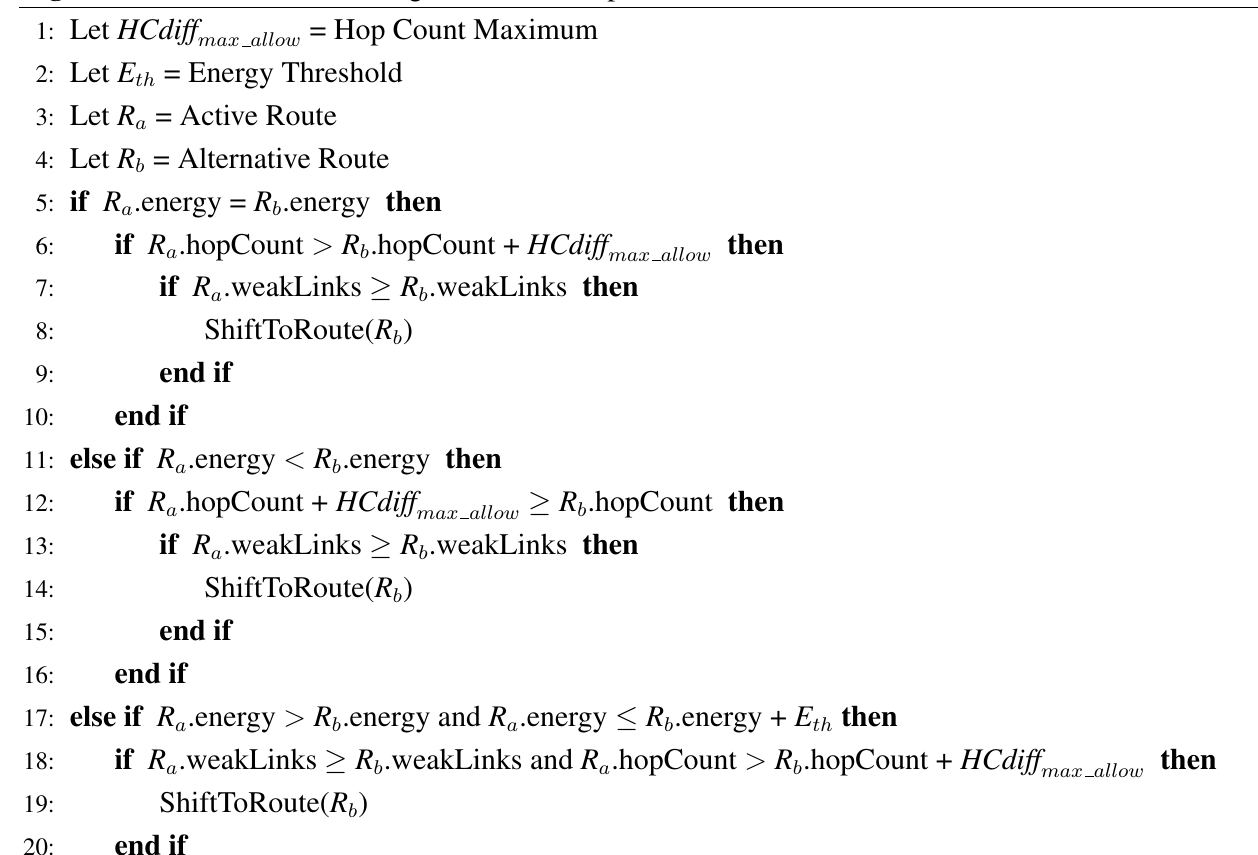
Algorithm 1 Selection Route Algorithm of REL